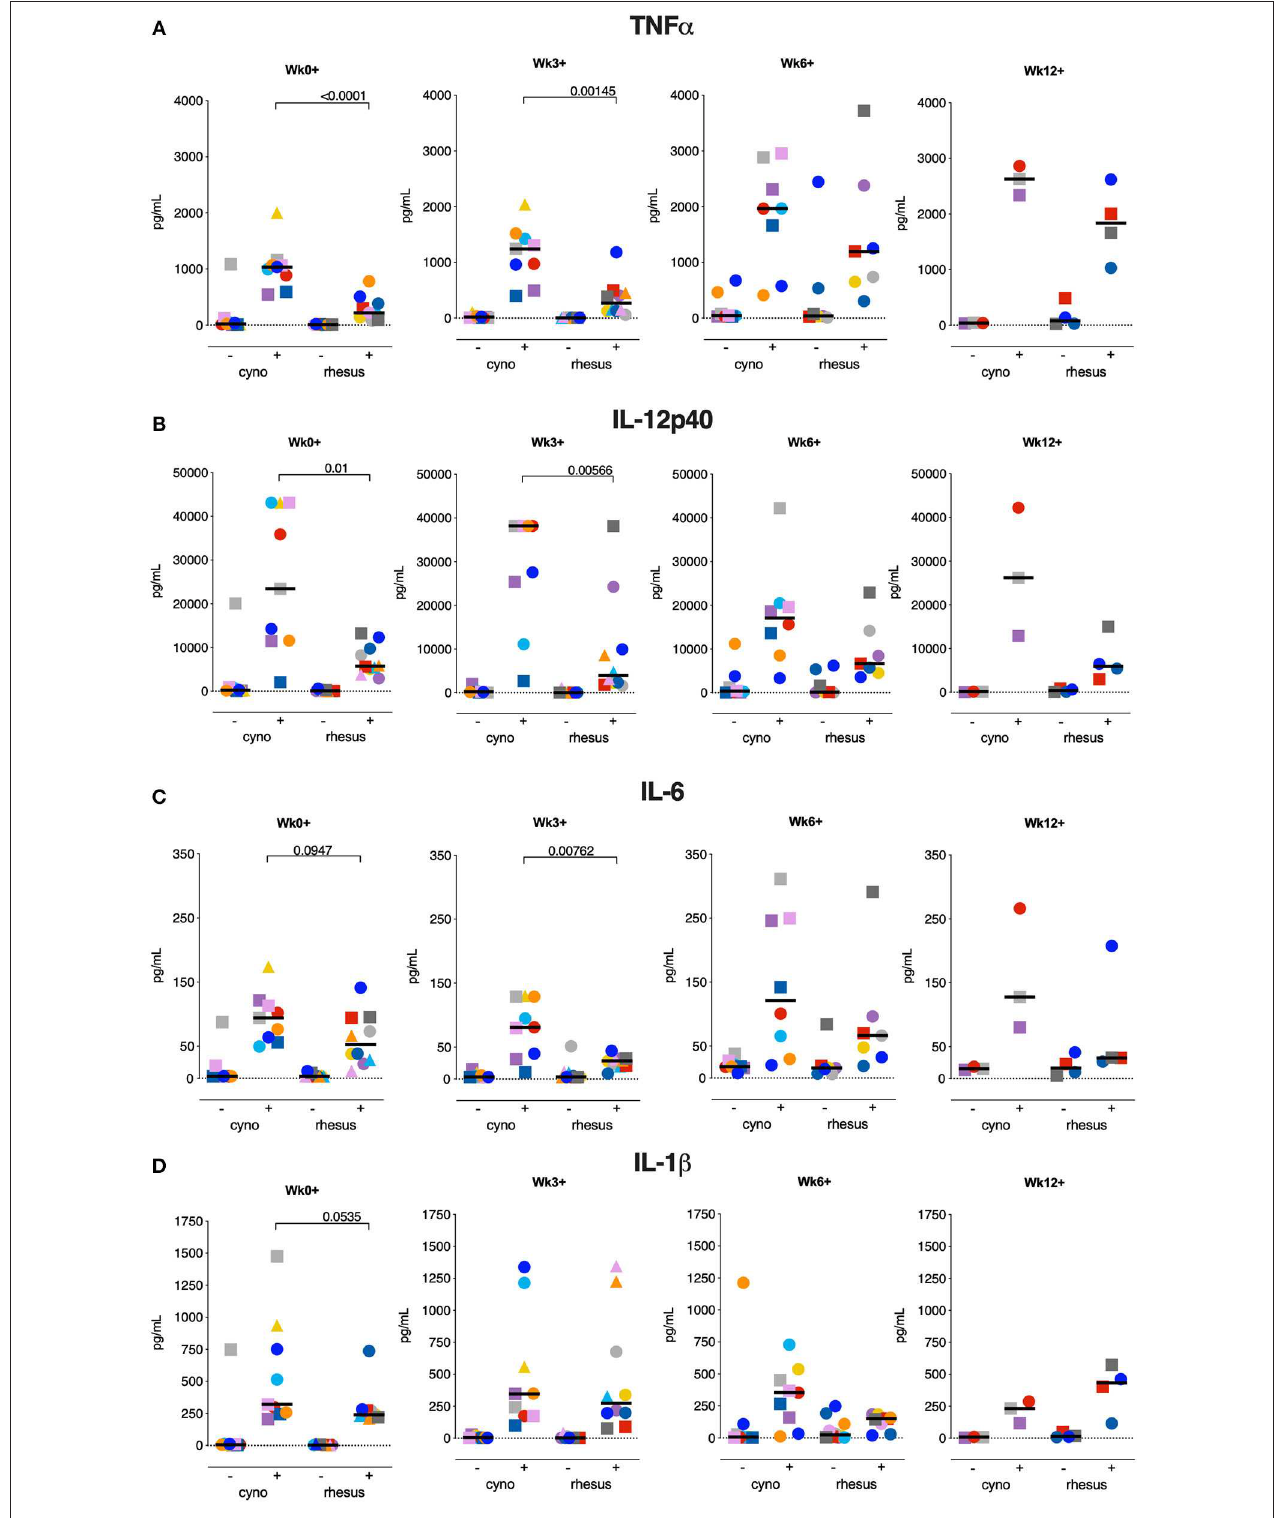
FIGURE 7 | Local innate cytokine production at the time of or early after Mtb infection is more prominent in cynomolgus macaques. Production of (A) TNF α , (B) IL6, (C) IL12p40, and (D) IL1 β by BAL cells after overnight stimulation with culture medium (–) or Mtb whole cell lysate ( + ). Data are aligned to the moment of each individual’s time point of infection take. Number of animals per time point varies due to sample availability. Horizontal lines indicate group medians. Significance of group differences was determined by two-sided Mann-Whitney test. Color coding per individual, as defined in Table 1 , is consistently applied throughout.